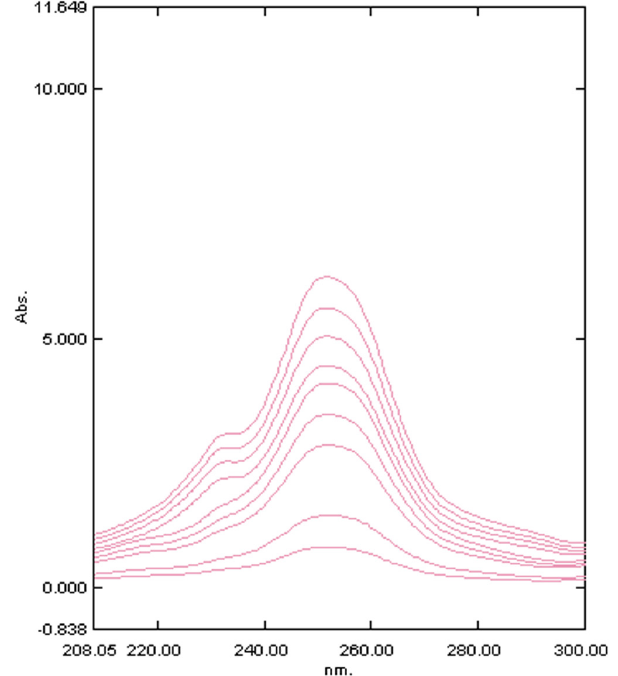
FIGURE 3 - Ratio spectra of DC by DS6.